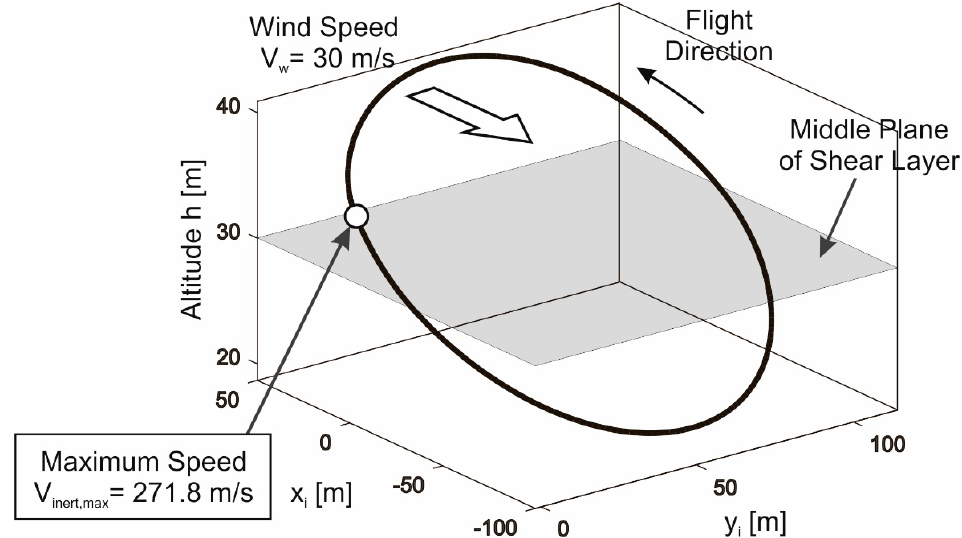
Figure 6. Dynamic soaring loop optimized for maximum speed, V inert , max = 271.8 m/s.